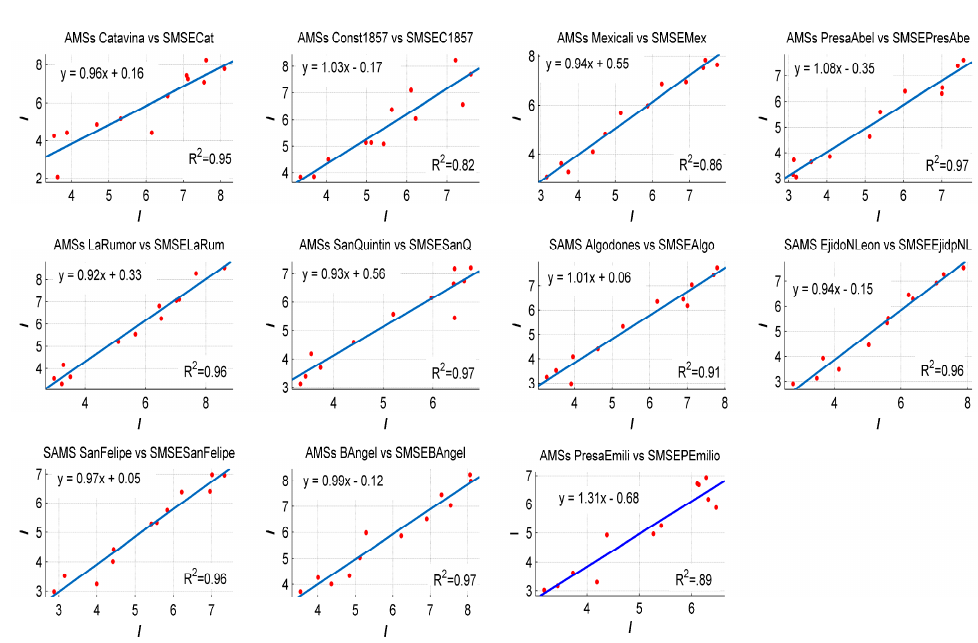
Figure 5. Monthly satellite versus measured data for each meteorological station in Baja California.